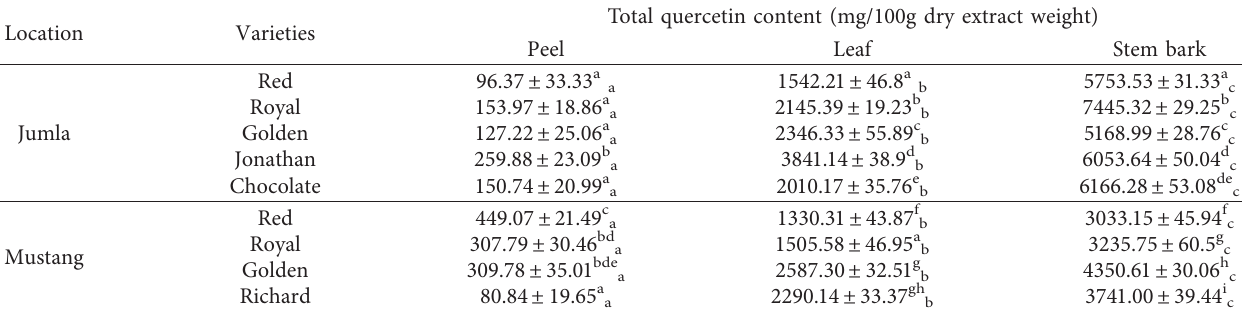
Table 9: Total quercetin content in peel, leaf, and stem bark extract of the M. domestica samples after acid hydrolysis.